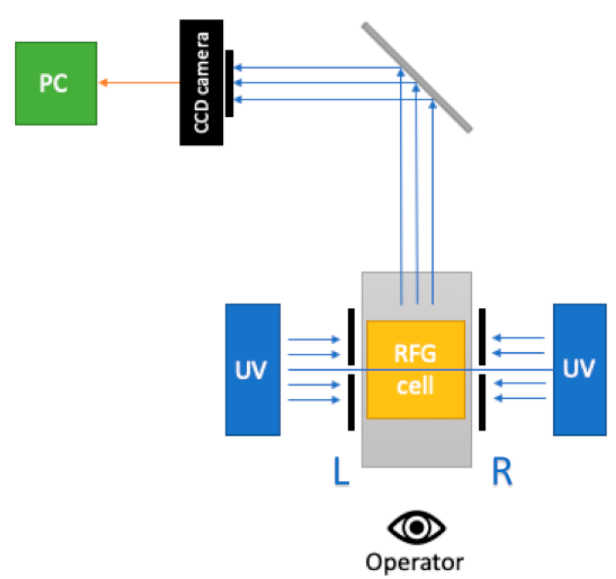
Figure 5. A schematic of the basic design of FluoroTome 1 with LED-array UV lamps, a CCD camera, and a translation stage in grey.